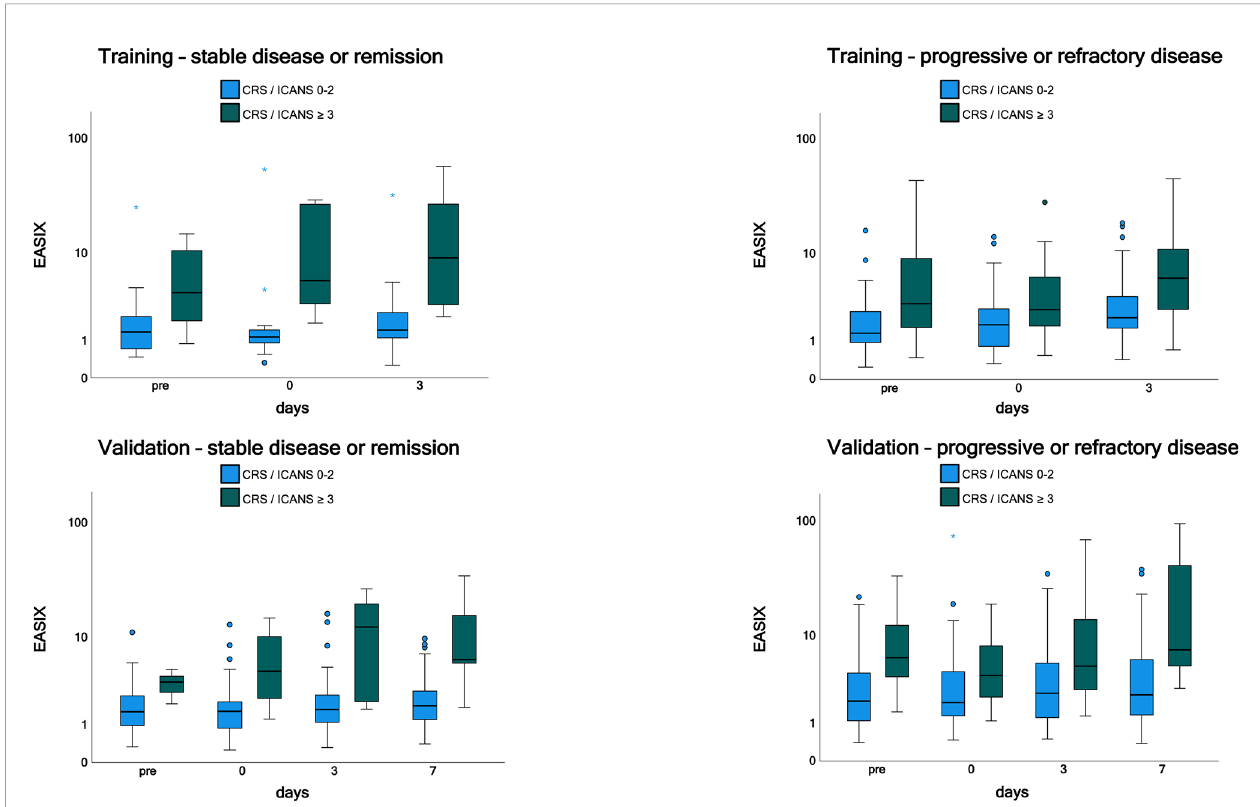
FIGURE 2 | EASIX measurement in the training and validation cohorts by disease status. Patients with progressive or refractory disease and patients with stable or sensitive disease were grouped according to CRS and/or ICANS grades 0-2 and ≥ 3. EASIX prior lymphodepletion, on the day of CAR-T cell application and on day 3 and 7 after application is shown. EASIX, Endothelial Activation and Stress Index; pre, prior lymphodepletion; CRS, cytokine release syndrome; ICANS, immune effector cell-associated neurotoxicity